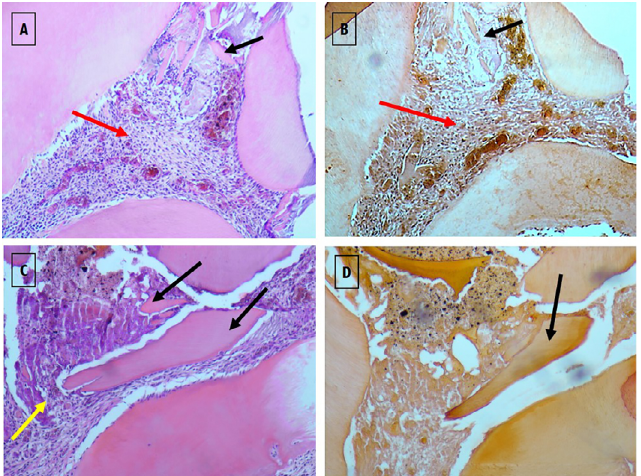
Figure 9- Images of histological sections in groups 3 (images A and B) and 4 (images C and D), in which therapies with WhiteProRoot ® MTA and Biodentine™ were performed, at 7 days of follow-up. Images A (Group 3) and C (Group 4) were stained with H&E and obtained with 100x magnification. The B (Group 3) and D (Group 4) images were stained with Alizarin Red S and obtained with 100x magnification. Black arrows – zones corresponding to mineralized tissue; red arrows – presence of slight inflammatory infiltrates and maintenance of tissue morphology; yellow arrow – intense inflammatory infiltrates in the